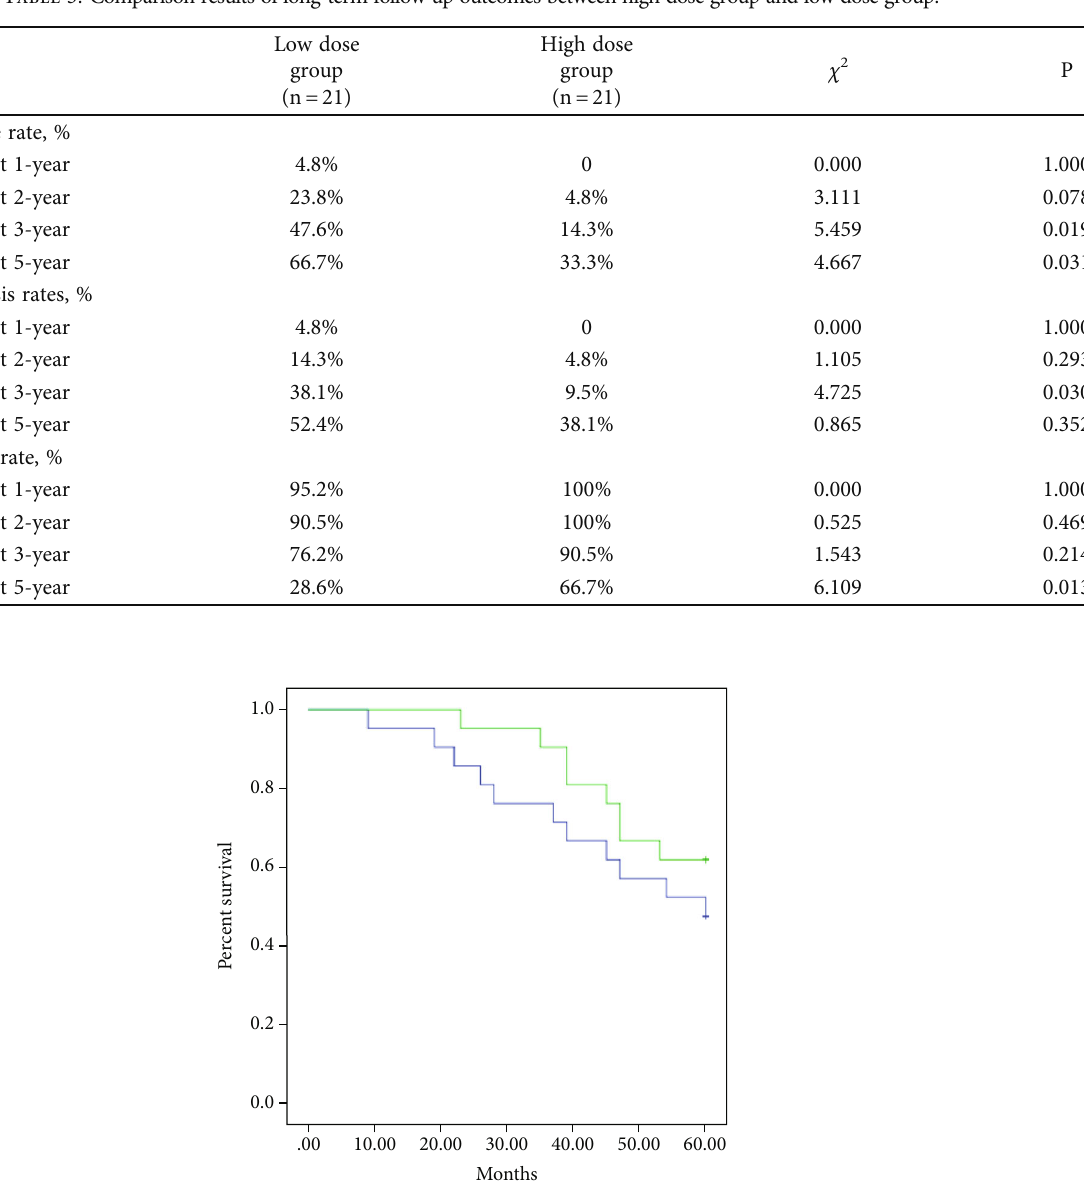
Table 3: Comparison results of long-term follow up outcomes between high dose group and low dose group.